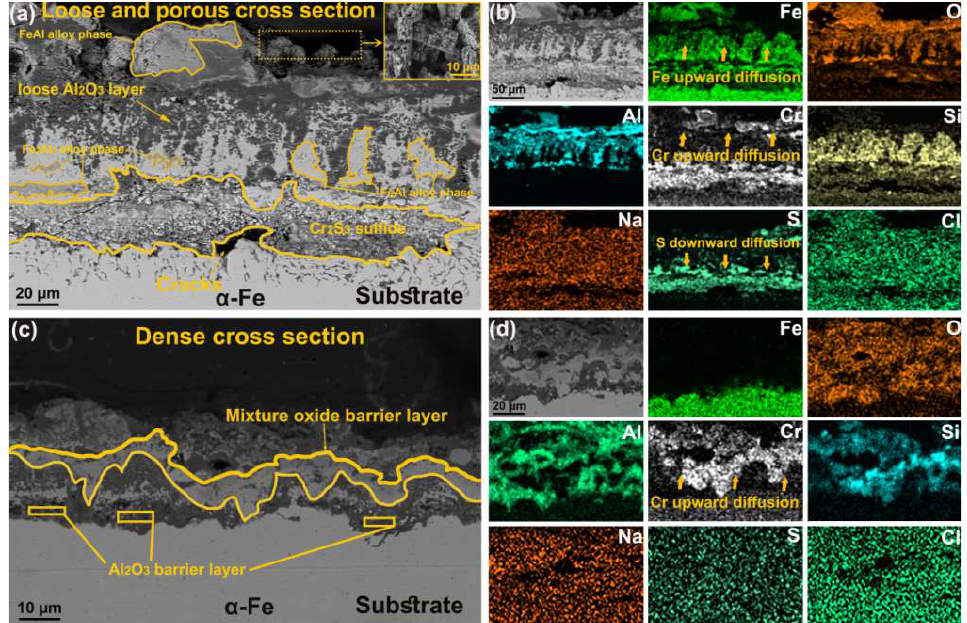
Figure 6. Cross-sectional SEM images and corresponding element mappings of all as-deposited coatings after 200 h salt corrosion test: ( a , b ) M1; ( c , d ) M2.